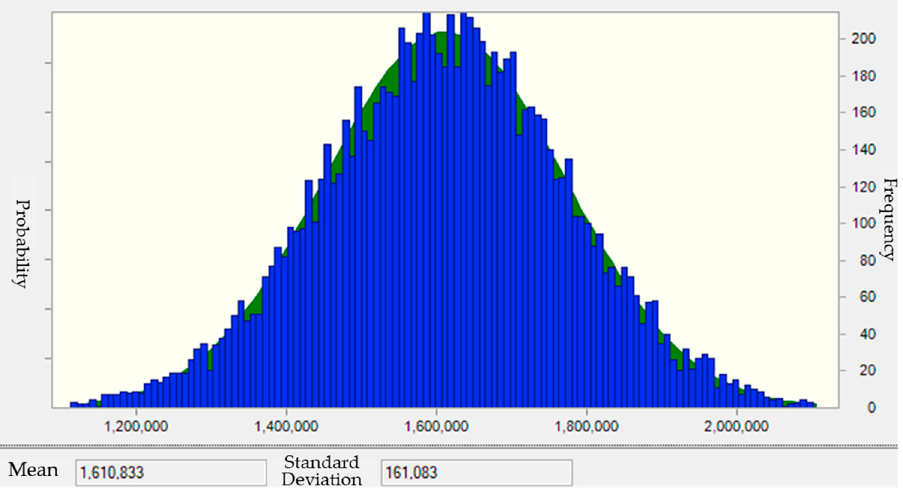
Figure 6. Probability distribution for commercial facility capital expenditure (CAPEX) (normal distribution).